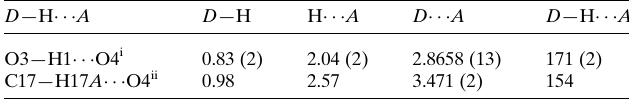
Table 1 Hydrogen-bond geometry (A˚ , (cid:3) ) for ( 2 ).